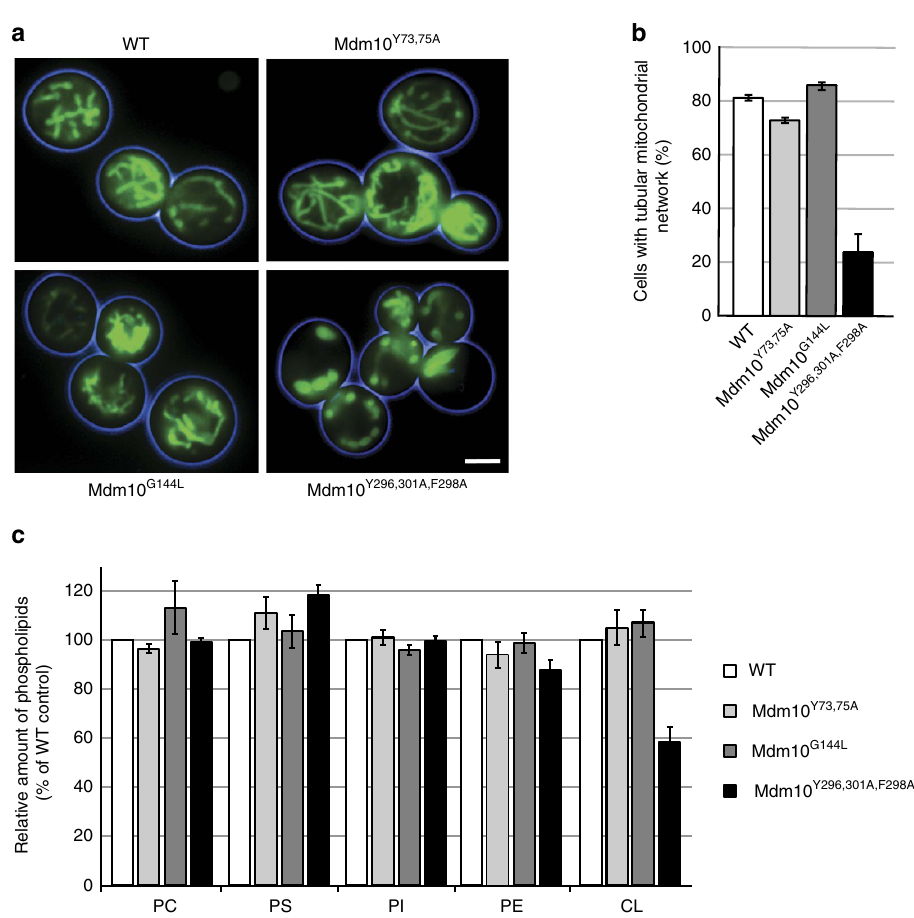
Figure 3 | Mdm10 at the ERMES complex is crucial for maintaining mitochondrial morphology and cardiolipin levels. ( a ) The mitochondrial morphology of yeast strains expressing wild-type (WT) or mutant forms of MDM10 was visualized by DiOC 6 staining and fluorescence microscopy. Scale bar, 5 m m. ( b ) Quantification of mitochondrial morphology based on fluorescence microscopy and staining with DiOC 6 . Relative amounts of cells with tubular network are depicted from three independent experiments with at least 300 cells analysed per strain, shown as mean ± s.e.m. ( c ) Yeast cells expressing WT or mutant forms of MDM10 were labelled with [ 33 P]orthophosphate for 90min at 37 (cid:2) C. After isolation of mitochondria, phospholipids were extracted and separated by thin-layer chromatography. Radiolabelled phospholipids were visualized by autoradiography. The amount of each major phospholipid is shown in relation to its WT level (set to 100%). Data are presented as mean ± s.e.m. ( n ¼